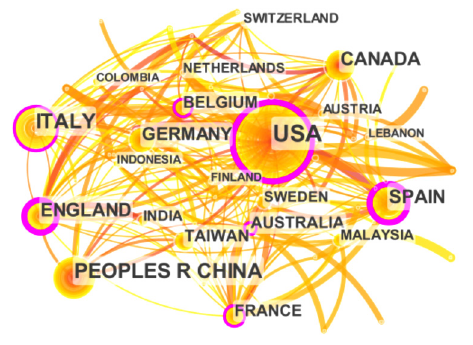
Figure 8. Co-authorship network of